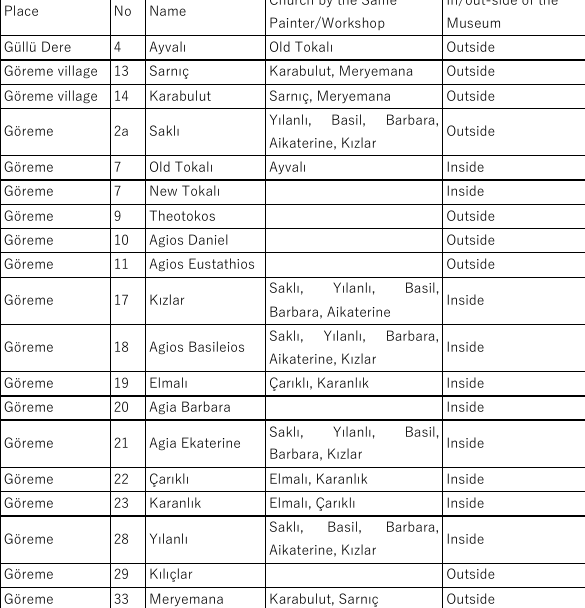
Table 13. The list of the nineteen churches with wall-painting and the similar examples of its wall-paintings in Göreme Valley (The number follows Jerphanion